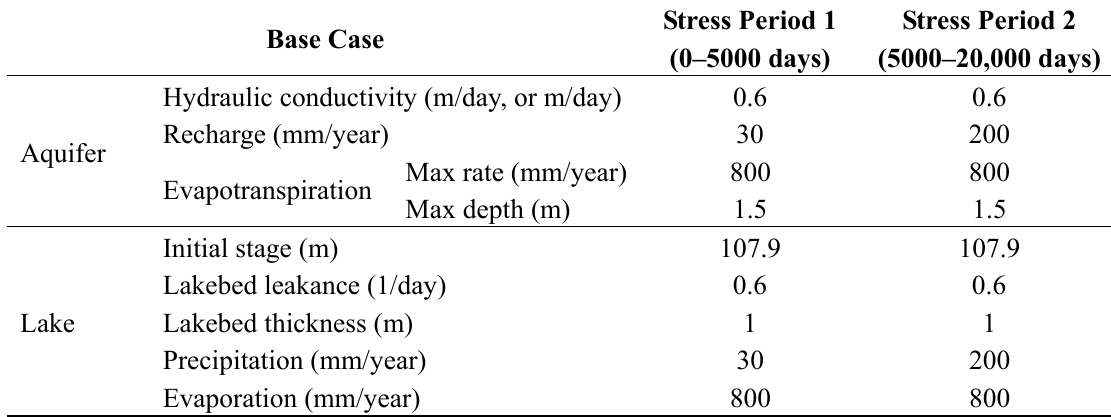
Table 1. Values of hydrological and hydraulic parameters for base case.